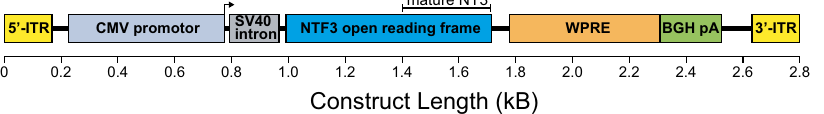
Figure 2. Schematic of the NT3 construct used in the creation of the viral vectors used in the present study. WPRE: woodchuck hepatitis virus posttranscriptional regulatory element; BGH pA: bovine growth hormone poly A; CMV: cytomegalovirus. ITR: inverted terminal